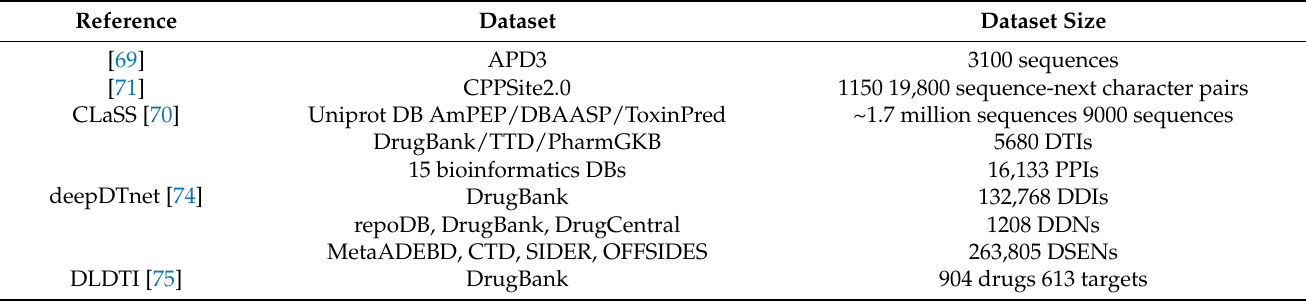
Table 2. A list of data used for training models for de novo peptide design and DTI